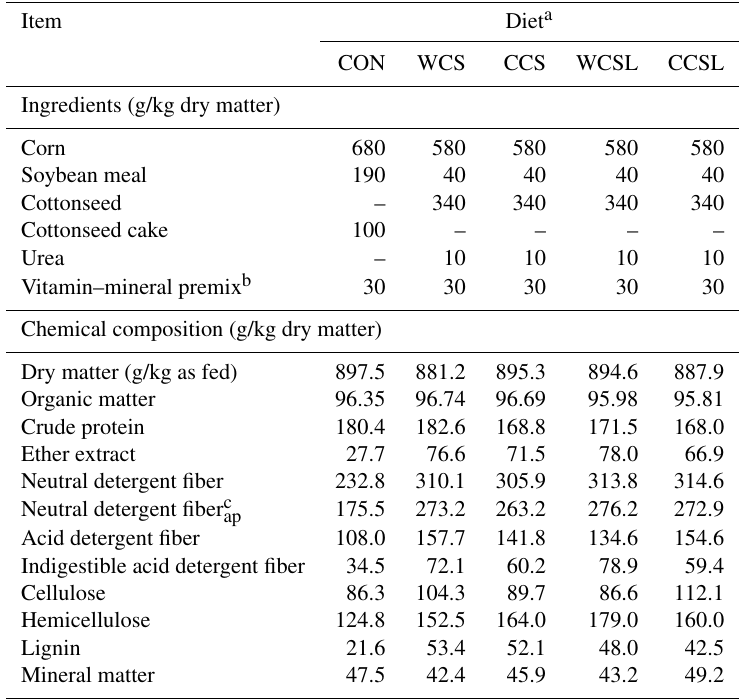
Table 1. Proportion of ingredients and physical and chemical composition of experimental diets.